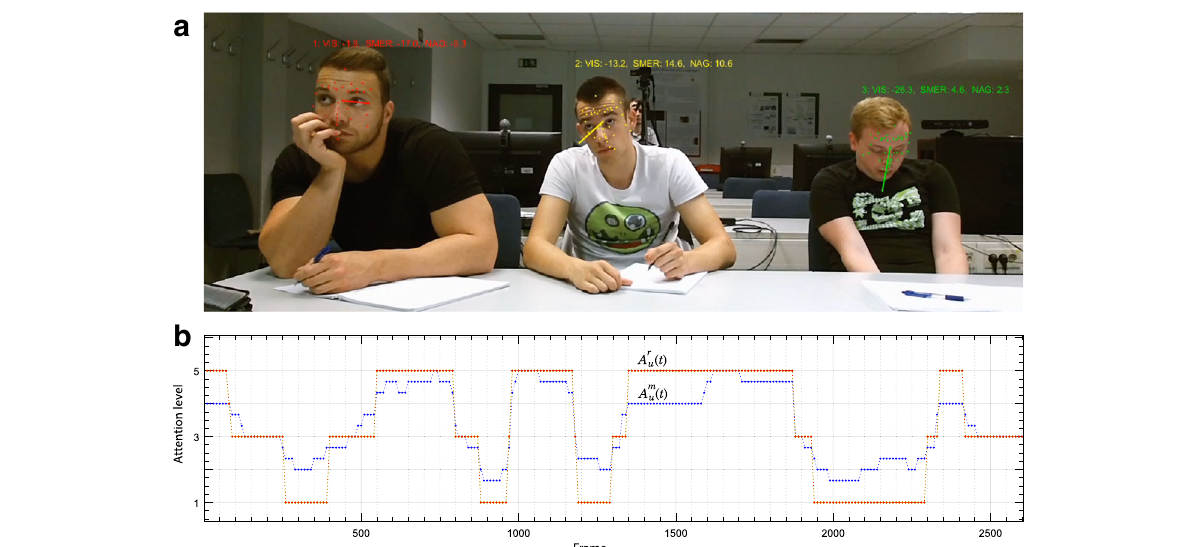
Fig. 2 Human estimation and annotation of person’s attention level. By observing video footage ( a ), five human coders estimated attention level of each of the test persons. On graph ( b ), mean attention score A m u ( t ) is shown as a blue line and final three-level reference attention A r u ( t ) as a red